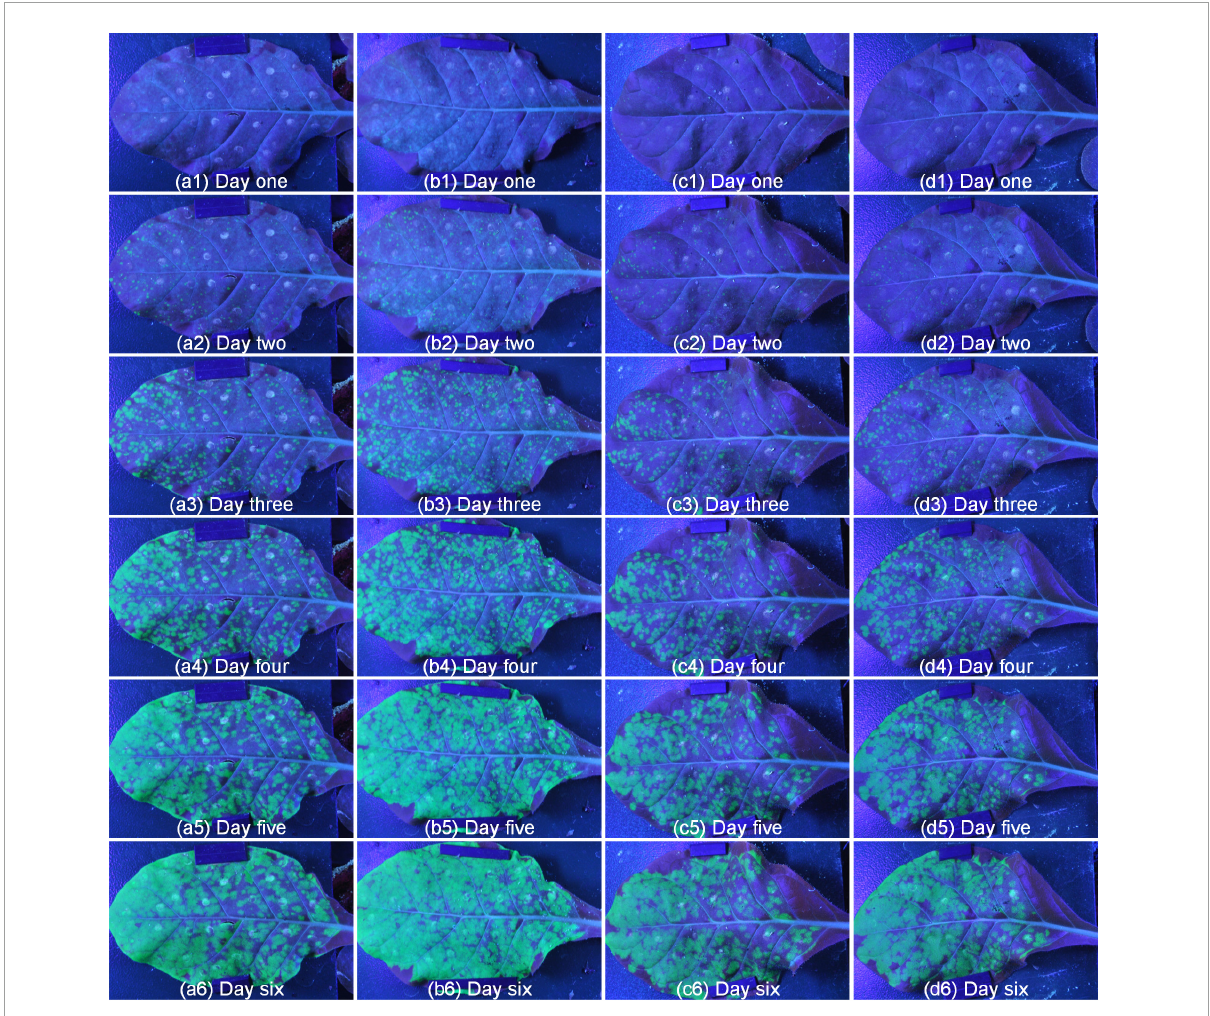
FIGURE7 The repeatability results of two different lines. Panels (a,b) represented different repetitions of the same line, panels (c,d) represented different repetitions of another line, number 1 to 6 represented different periods.